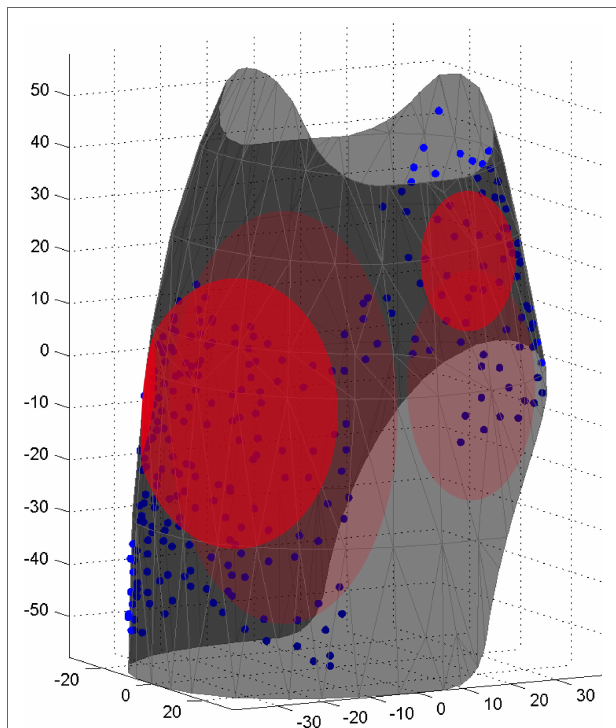
FIGURE 5 | An example of the 3D receptive fields of iCub forearm using generic robotic skin interface . The blue dots are the taxels, and the four circular areas are receptive fields.